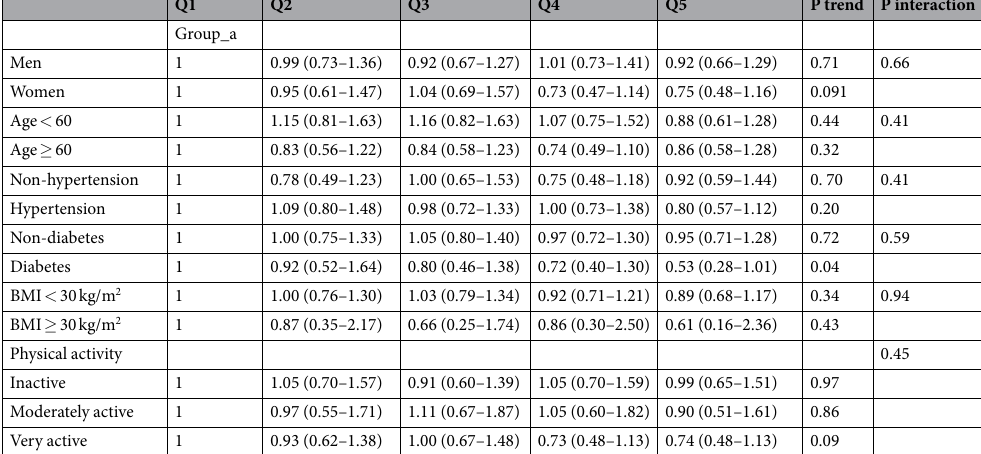
Table 3. Multivariate-adjusted odd ratios for ICAS based on HDL-C levels, classified by gender and chosen risk elements. Model 1: Multivariate-adjusted odd ratios (OR): adjusted for gender, age, hypertension, DM, SBP, DBP, FBG, LDL-C, TC, TG, BMI, family history of myocardial infarction, and physical